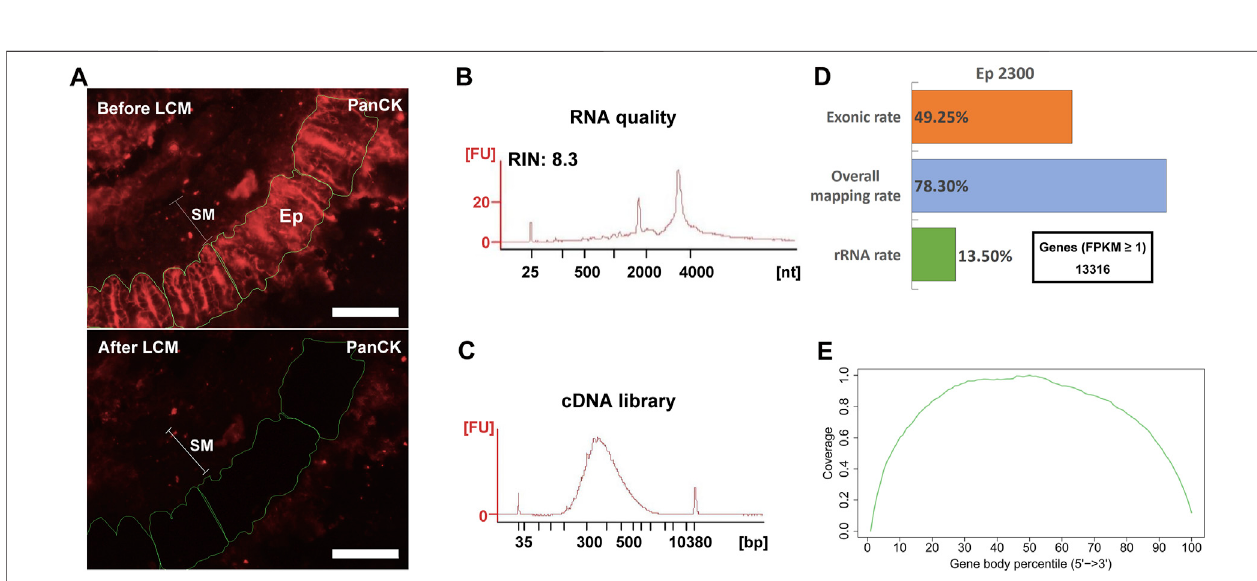
FIGURE5 | Immumo-LCM-RNAseq with ~2300 cytokeratin positive epithelial cells (Ep2300). (A) Atypical anti-PanCK stained fl uorescence section before (upper) and after (lower) laser microdissection. SM: submucosal layer; Ep: cytokeratin positive cells. Scale bar: 100 μ m. An image showing the nuclei stained with Hoechst is shown in Supplementary Figure S6 . (B) High RNA quality of the leftover materials after microdissection. (C) cDNA library quality assessment. (B) and (C) were obtained with the 2100 Bioanalyzer. (D) Summary of the sequencing data quality with more than 13,000 expressed genes detected. (E) As expected from the Ovation SoLo system, normal reads coverage over the transcripts was obtained without 3 ′ enrichment. This coverage is required for full transcript and isoform analysis.